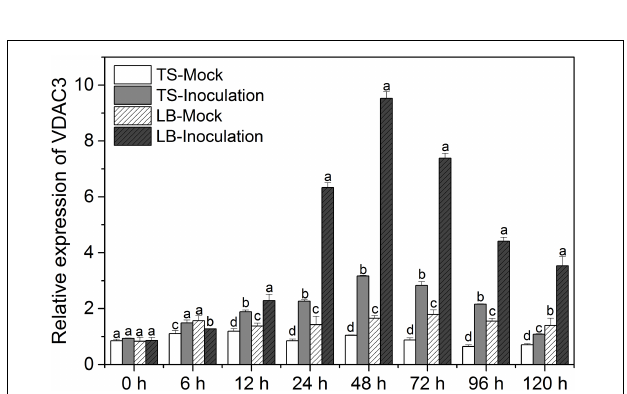
FIGURE 3 | Expression profiles of the VvVDAC genes in the tissues/organs of grapevine during the developmental stages. Data were normalized based on the mean expression value of each gene in all tissues analyzed. Red and green boxes indicate high and low expression levels, respectively. BerryPericarp-FS, berry pericarp fruit set; BerryPericarp-PFS, berry pericarp post-fruit set; BerryPericarp-V, berry pericarp véraison; BerryPericarp-MR, berry pericarp mid-ripening; BerryPericarp-R, berry pericarp ripening; Bud-S, bud swell; Bud-B, bud burst (green tip); Bud-AB, bud after burst (rosette of leaf tips visible); Bud-L, latent bud; Bud-W, winter bud; BerryFlesh-PFS, berry flesh post fruit set; BerryFlesh-V, berry flesh véraison; BerryFlesh-MR, berry flesh mid-ripening; BerryFlesh-R, berry flesh ripening; BerryFlesh-PHWI, berry flesh post-harvest withering I (1st month); BerryFlesh-PHWII, berry flesh post-harvest withering II (2nd month); BerryFlesh-PHWIII, berry flesh post-harvest withering III (3rd month); Inflorescence-Y, young inflorescence; Inflorescence-WD, well-developed inflorescence; Flower-FB, flowering begins; Flower-F, flowering; Leaf-Y, young leaf; Leaf-FS, mature leaf; Leaf-S, senescing leaf; BerryPericarp-PHWI, berry pericarp post-harvest withering I (1st month); BerryPericarp-PHWII, berry pericarp post-harvest withering II (2nd month); BerryPericarp-PHWIII, berry pericarp post-harvest withering III (3rd month); Rachis-FS, rachis fruit set; Rachis-PFS, rachis post-fruit set; Rachis-V, rachis véraison; Rachis-MR, rachis mid-ripening; Rachis-R, rachis ripening; Seed-V, seed véraison; Seed-MR, seed mid-ripening; Seed-FS, seed fruit set; Seed-PFS, seed post-fruit set; BerrySkin-PFS, berry skin post-fruit set; BerrySkin-V, berry skin véraison; BerrySkin-MR, berry skin mid-ripening; BerrySkin-R, berry skin ripening; BerrySkin-PHWI, berry skin post-harvest withering I (1st month); BerrySkin-PHWII, berry skin post-harvest withering II (2nd month); BerrySkin-PHWIII, berry skin post-harvest withering III (3rd month); Stem-G, green stem; Stem-W, woody stem; Tendril-Y, young tendril; Tendril-WD, well-developed tendril; Tendril-FS, mature tendril.